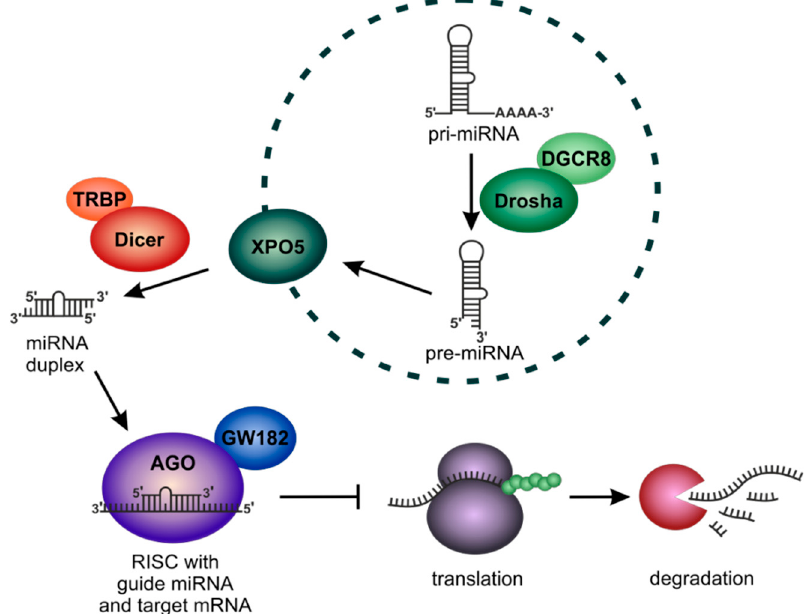
Figure 1. MiRNA processing pathway. Long primary miRNA transcripts (pri-miRNA) are processed in the nucleus by Drosha and DGCR8 [43–46]. The pre-miRNA is transferred into the cytoplasm by Exportin 5 (XPO5) and further processed by Dicer and TRBP [47,48]. The resulting miRNA duplex is loaded onto AGO at which point one strand is degraded [51,52]. The remaining mature miRNA strand forms the “RNA induced silencing complex” (RISC) together with AGO and GW182 [51,53]. The main function of the RISC is the translational repression of complementary target mRNAs [54].